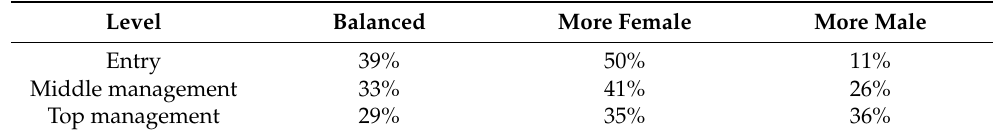
Table 4. Gender balance at different organisational